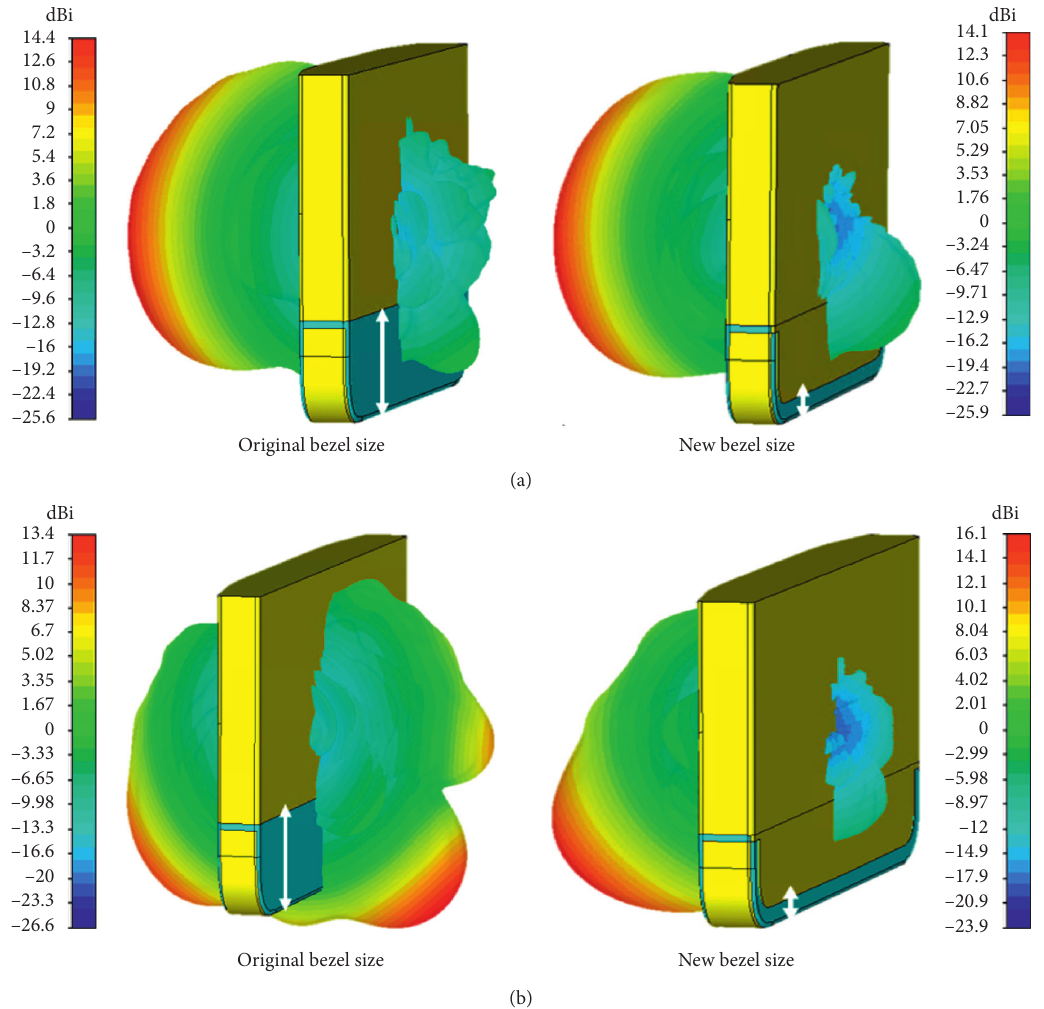
Figure 6: Antenna array radiation patterns for ψ � 90 ° with altered bezel sizes. Each plot’s colorbar refers to its maximum value with a common dynamic range of 40dB: (a) PBS; (b) MBS.